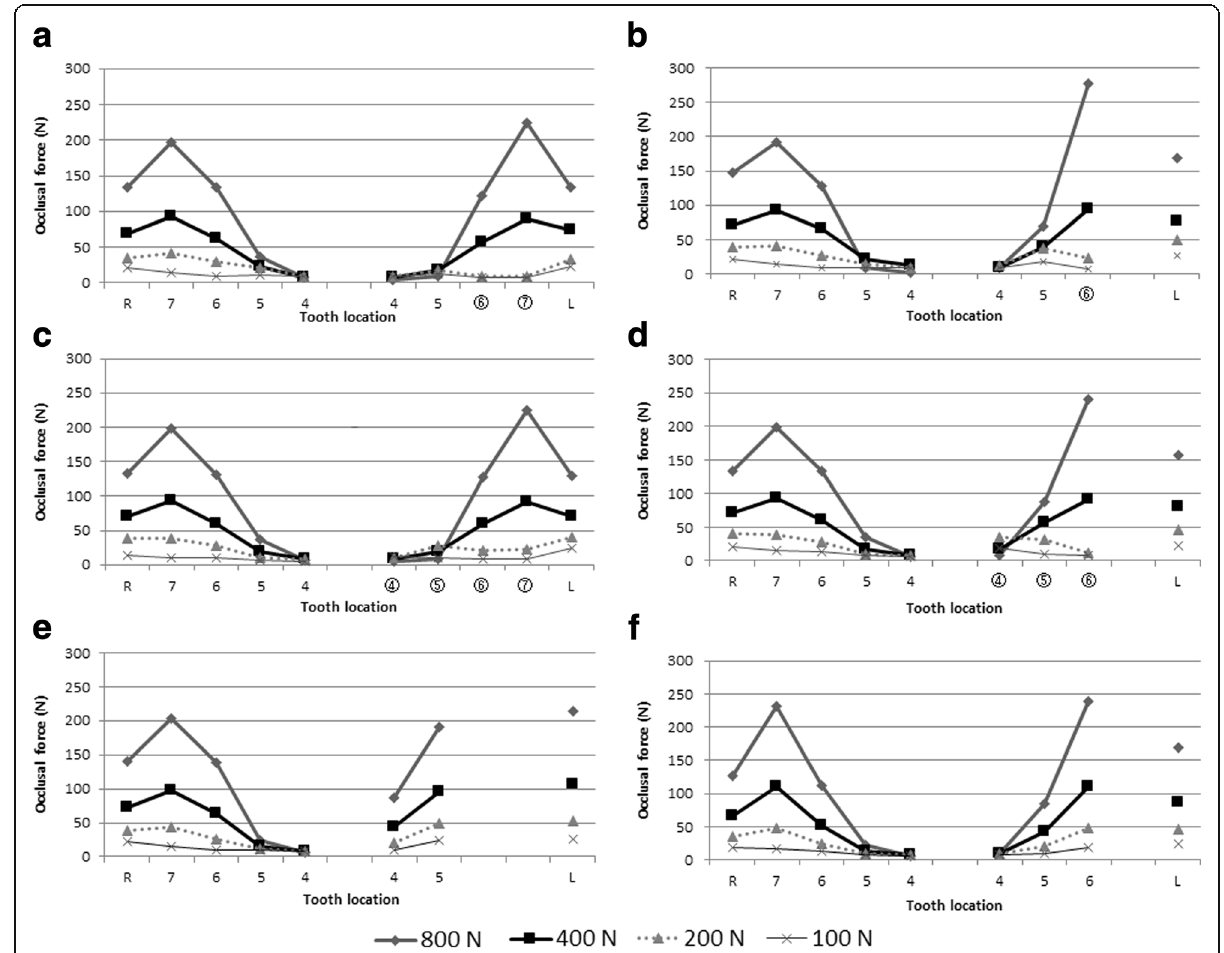
Fig. 8 Distribution of occlusal force in models. a Im67, b Im6, c Im4567, d Im456, e MT67, and f MT7. R right TMJ, L left TMJ, 4 first premolar, 5 second premolar, 6 first molar, and 7 second molar. Numbers within circles indicate implant